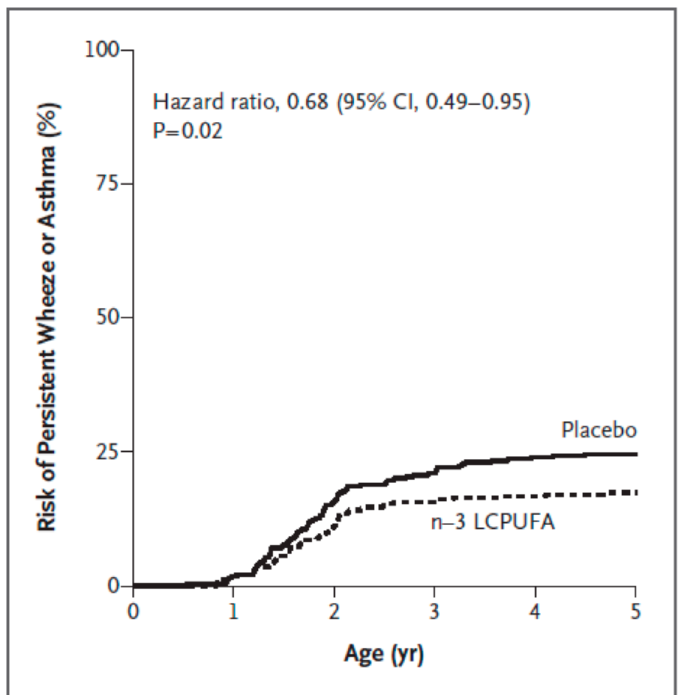
Figure 5. Risk of persistent wheeze or asthma in children according to maternal use of fish oil or placebo during pregnanacy. From New England Journal of Medicine, H. Bisgaard, J.